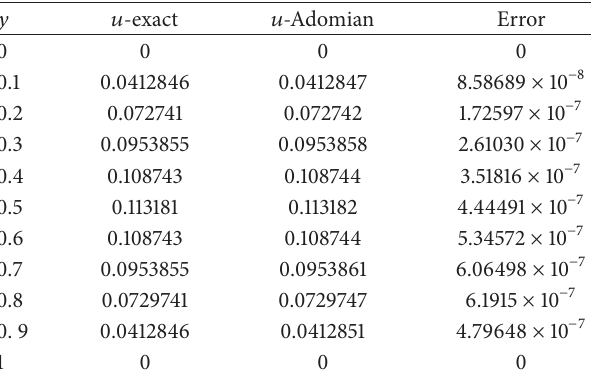
Figure 1:Entropygeneration ratefordifferent porositypermeability parameter.